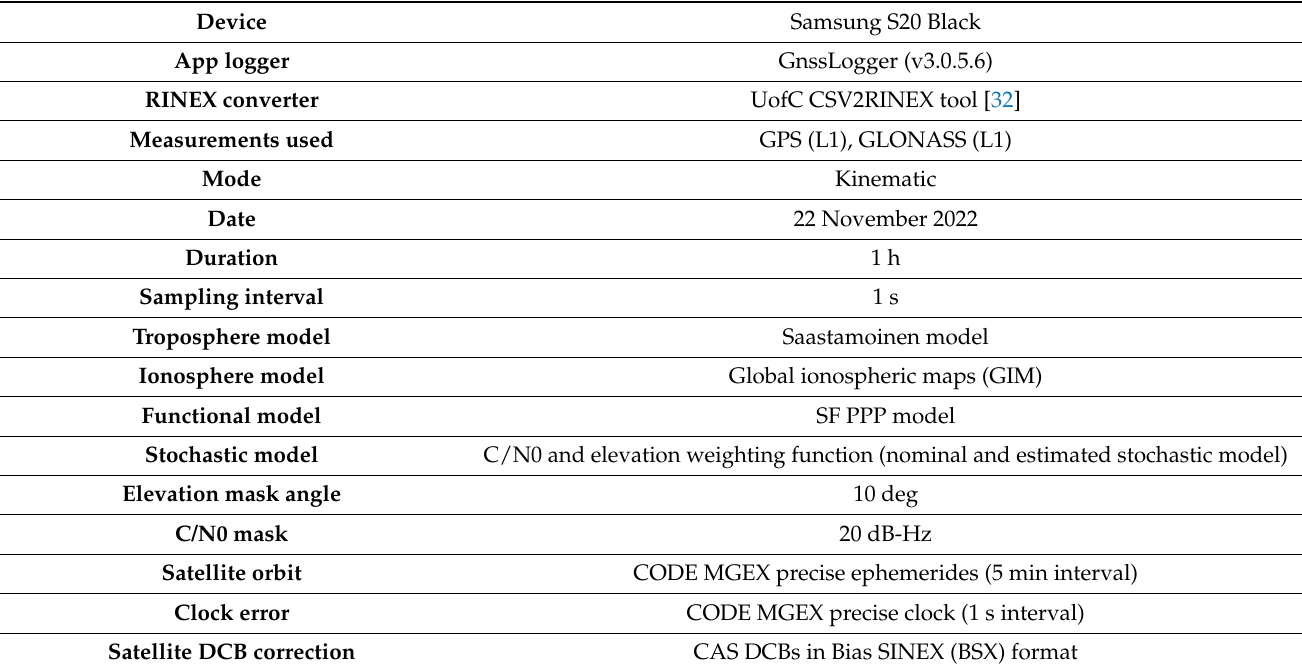
Table 6. GNSS data information and processing